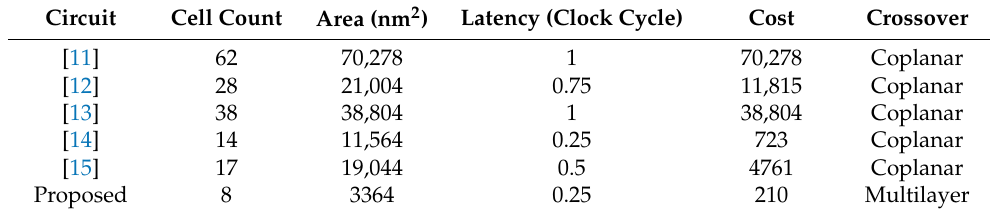
Table 4. Comparison of XOR gates.